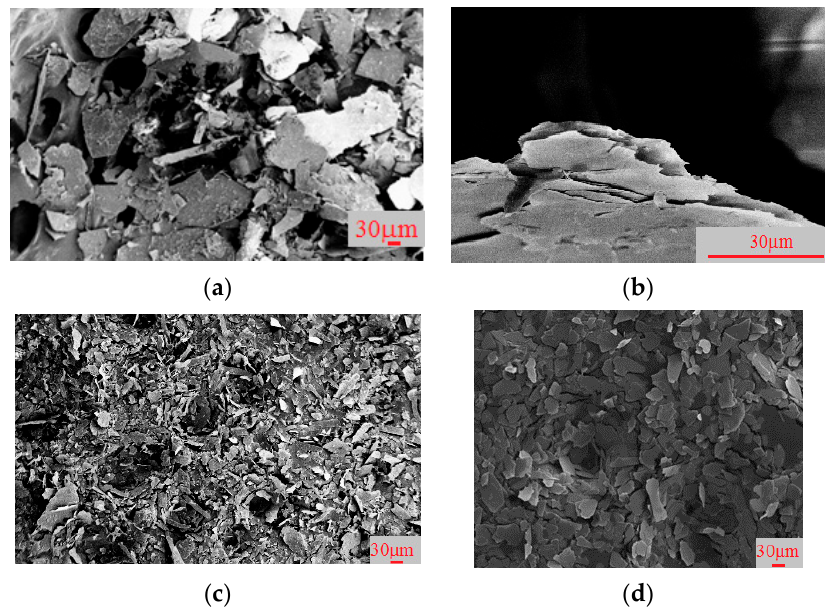
Figure 9. SEM images of mica particles. ( a ) Initial; ( b ) particles after electrochemical treatment; ( c ) particles after grinding; ( d ) after sieving. Translated with www.DeepL.com/Translator (free version).